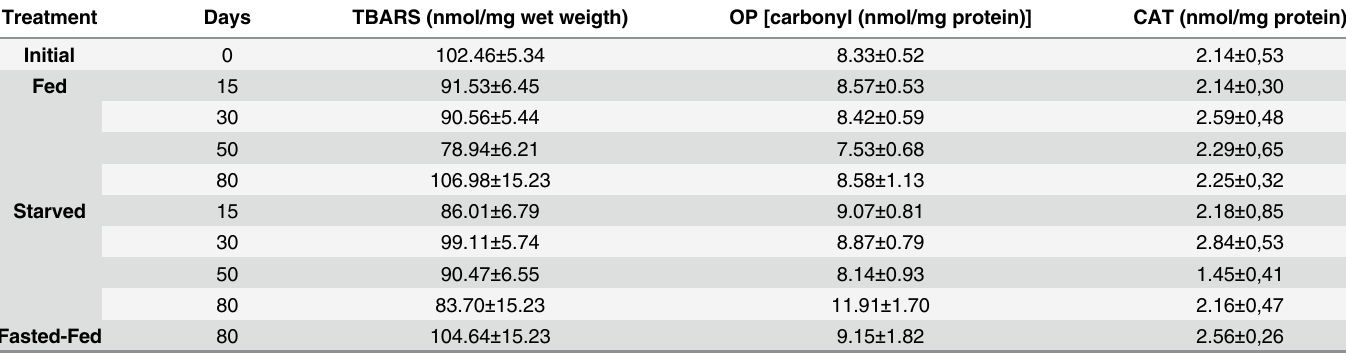
Table 2. Cherax quadricarinatus juveniles´ lipid peroxidation and protein oxidation levels and catalase activity after starvation and posterior feeding.